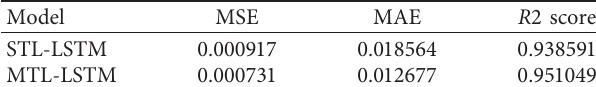
Figure 8: The change of iteration loss of training set and verifi- cation set. Table 1: The performance comparison of fault diagnosis models.